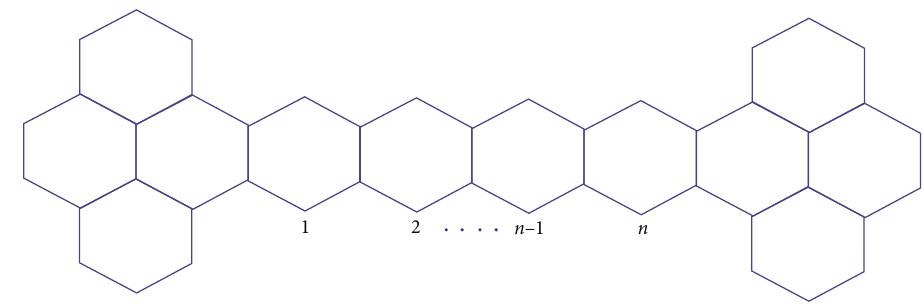
Figure 2: Structure of hammer-like benzenoid H